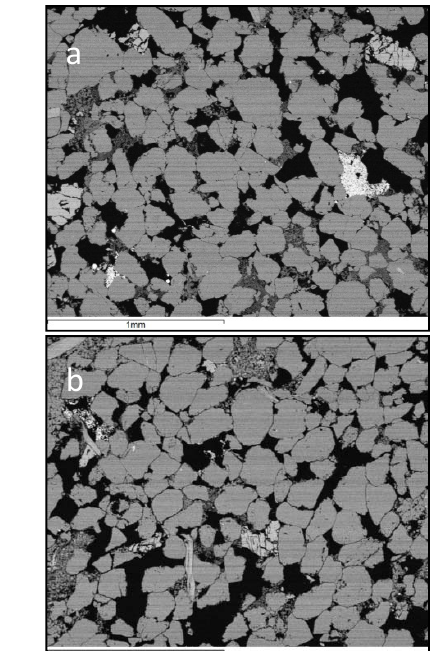
Figure 3. SEM ‐ Backscattered Electron images of sandstone: a) a control sample and b), a sample that was exposed to 900 o C for 4 hours. This was used to assess the effects of fire damage on stone as part of a comprehensive analysis of the mechanical and compositional effects. There is a suggestion in these images of a separation of grains in the sample exposed to elevated temperature, that may correlate with observation of changes in other physical and mechanical measurements (author’s own